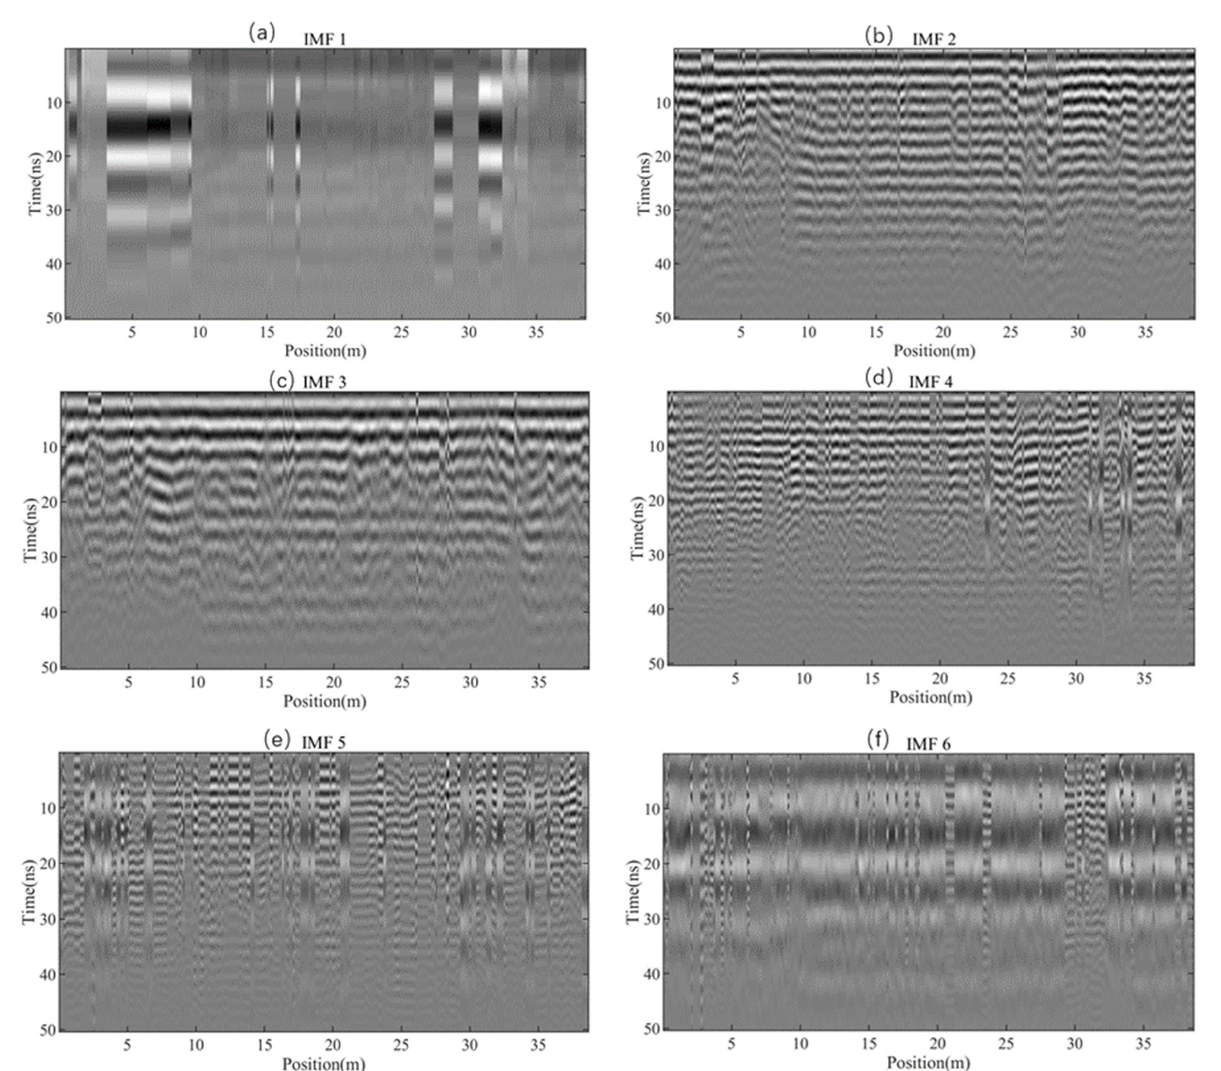
Figure 6. Determination of the optimal combination of (cid:4670)𝐾 , 𝛼(cid:4671) by PSO for the average trace in Fig ‐ ure 5. ( a ) Initial position of the ten particles, ( b ) The change of local minimum entropy value with population evolution generation, ( c ) the final position of the particles with the optimum value is marked in the red circle.